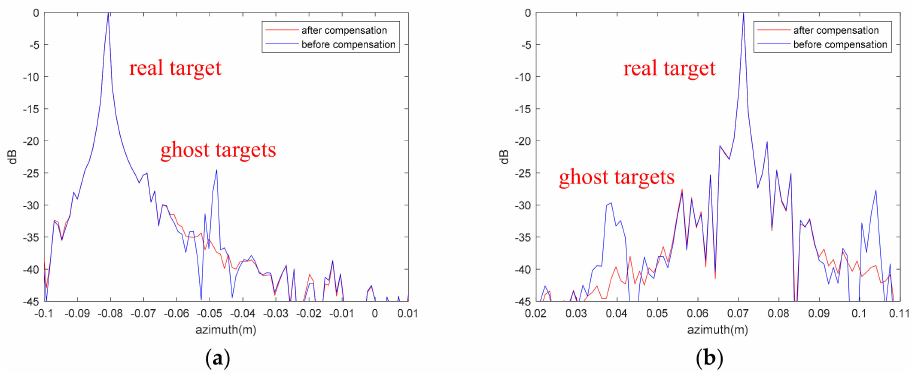
Figure 36. Azimuth profiles of T 1 ( a ) and T 2 ( b ) without and with